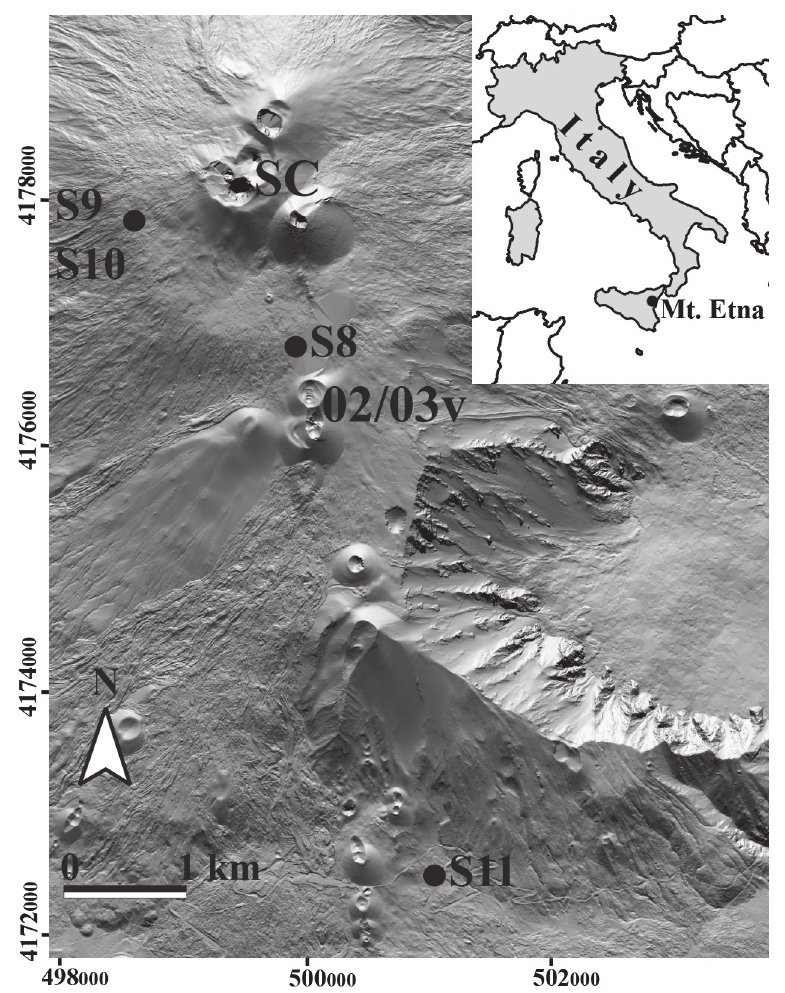
Fig. 2. Location of sampled sites at Mt. Etna. The shaded image is derived from September 2004 LiDAR el- evation data (Mazzarini et al. , 2007). SC: summit craters; 02/03v: vents formed during the 2002-2003 eruption (Andronico et al. , 2005). Image is illuminated from north and georeferred in UTM projection, Zone 33 N, WGS 84 datum, labels in left and in bottom sides of figure are UTM coordinates